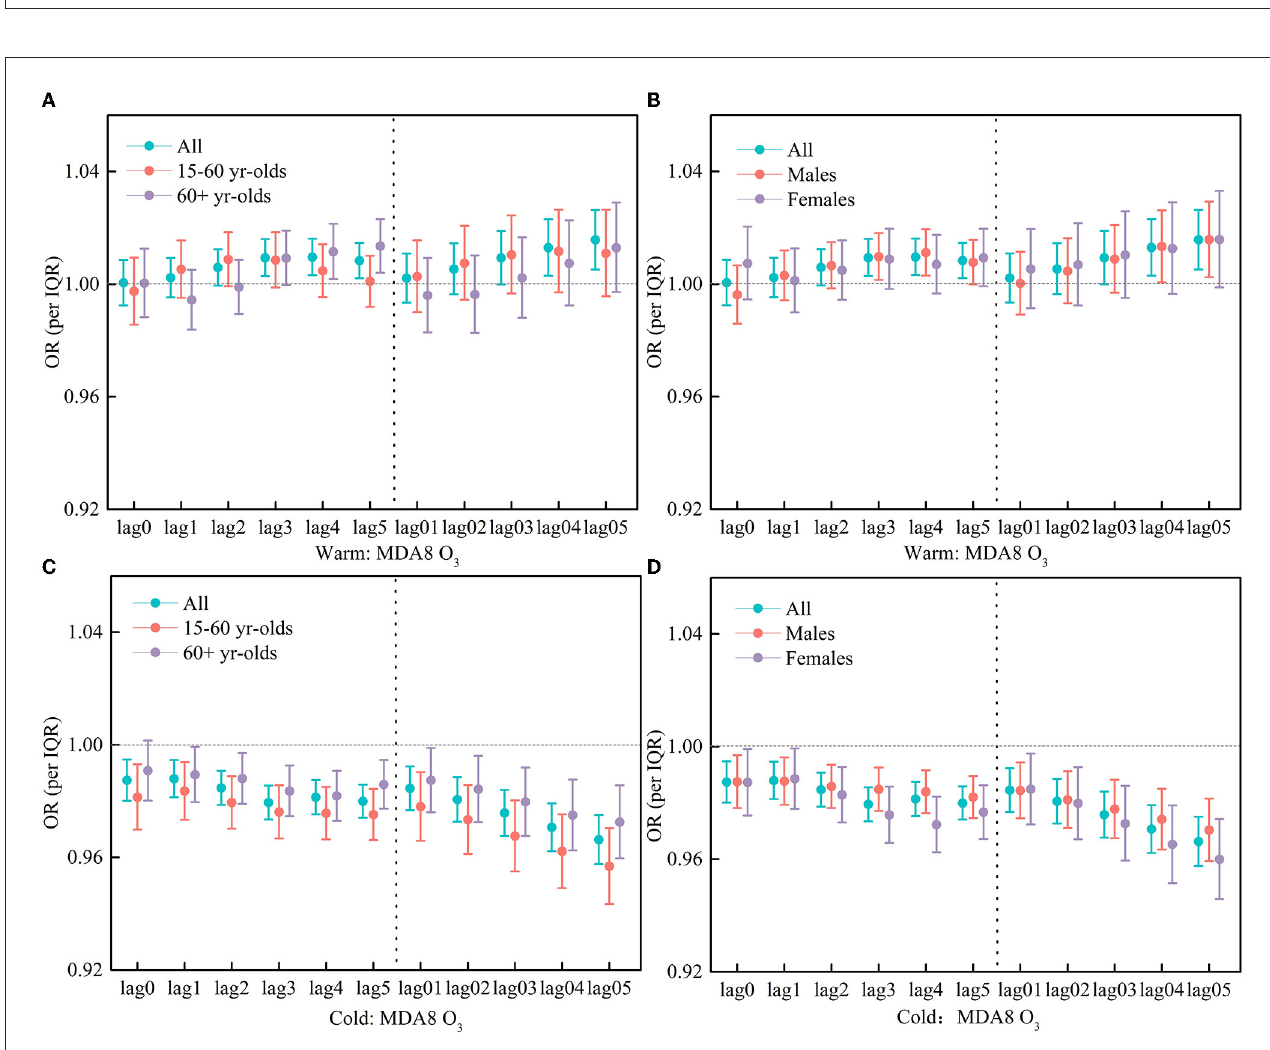
FIGURE4 (A–D) OR of respiratory hospitalization visits for an increase of per IQR in MDA8 O3 during the warm periods (May to October) and the cold periods (November to